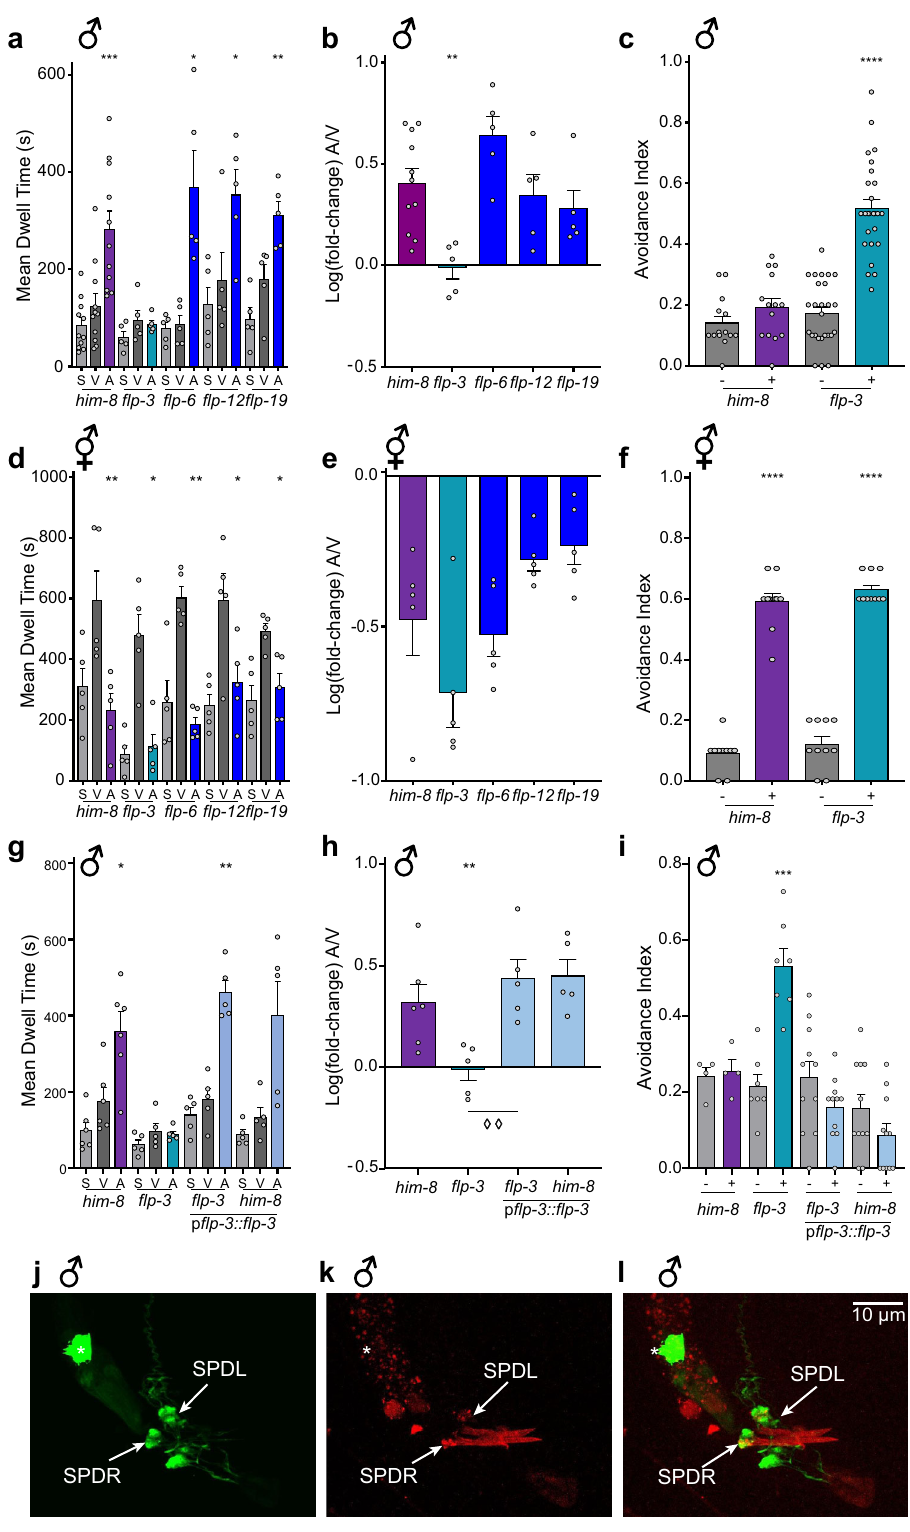
neuropeptide within male-speci fi c spicule neurons 34,45 (Fig. 2j – l, Supplementary Fig. 6a – c). Transcriptional reporters have shown robust fl p-3 expression in the amphid IL1 neurons, as well as the sensory PQR and the male-speci fi c interneuron, CP9, although